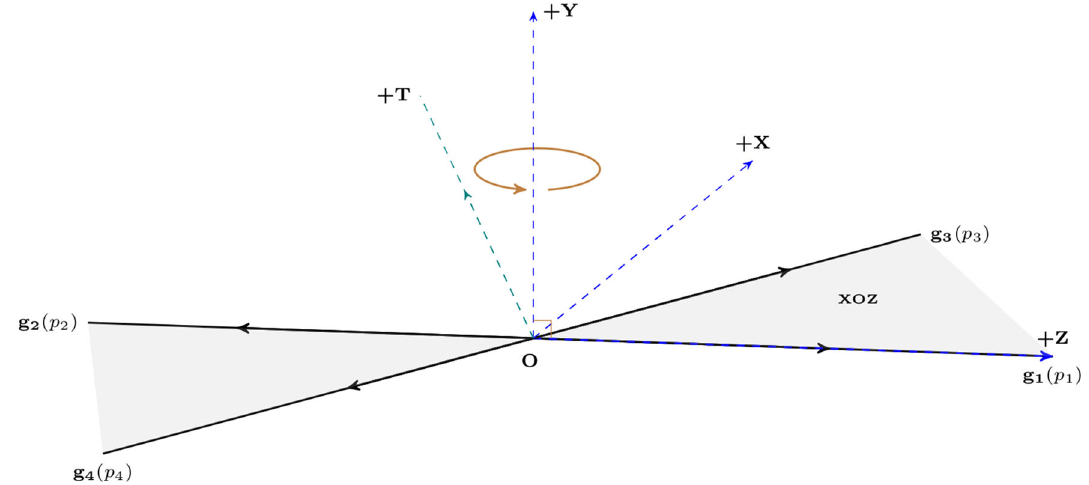
Fig. 1 The chosen coordinate system in the center-of-mass reference frame of the two incoming